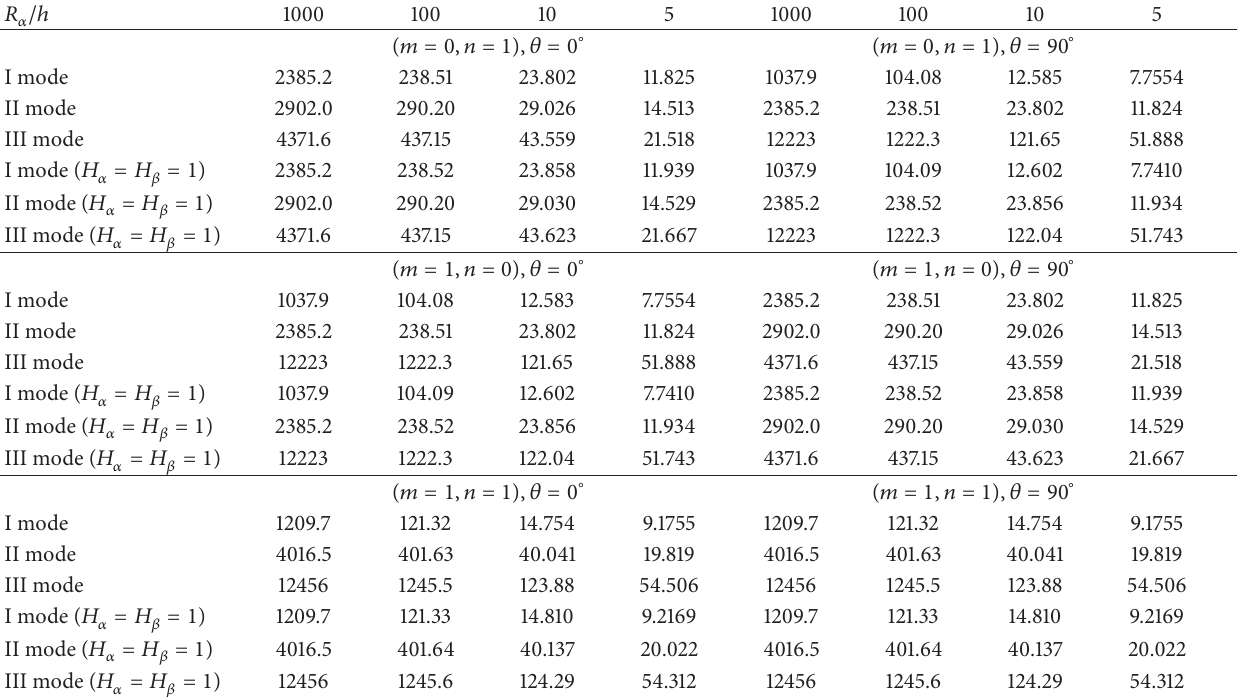
Table 16: Effects of 𝐻 𝛼 = (1 + 𝑧/𝑅 𝛼 ) and 𝐻 𝛽 = (1 + 𝑧/𝑅 𝛽 ) terms in benchmark 10 for simply supported orthotropic spherical shell panel. First three vibration modes in term of no-dimensional circular frequency 𝜔 = 𝜔(𝑎 2 /ℎ)√𝜌/𝐸 2 for several combinations of half-wave numbers 𝑚 and 𝑛 . 𝑀 = 100 fictitious layers and 𝑁 = 3 order of expansion for the exponential